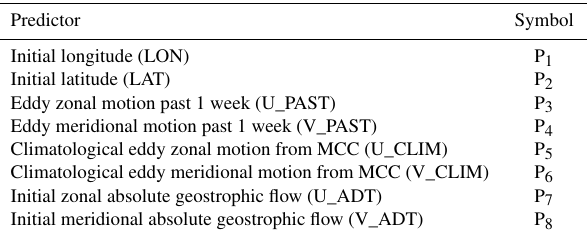
Table 3. Normalized regression coefficients a i,j ( b i,j ) for use with the eddy zonal (meridional) motion prediction